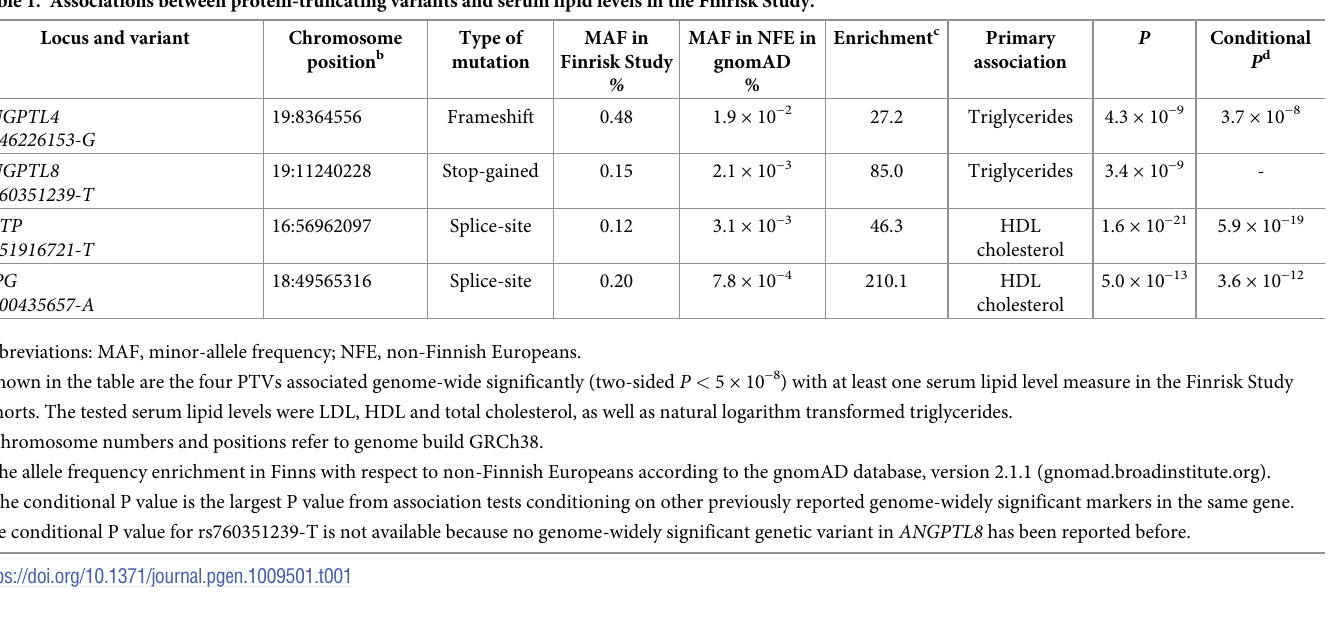
Table 1. Associations between protein-truncating variants and serum lipid levels in the Finrisk Study. a